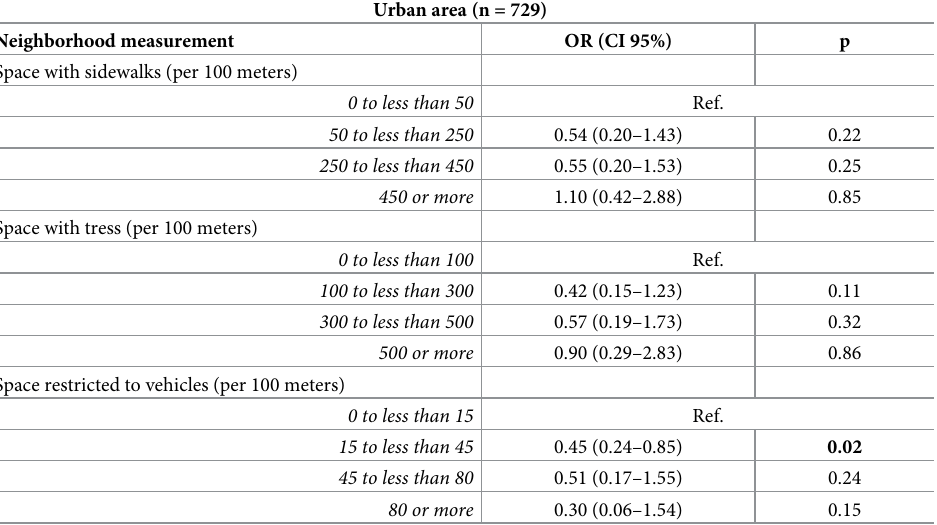
Models with state as the second aggregation level and adjusted for sex, age, income index, functional limitations and deprivation index of the